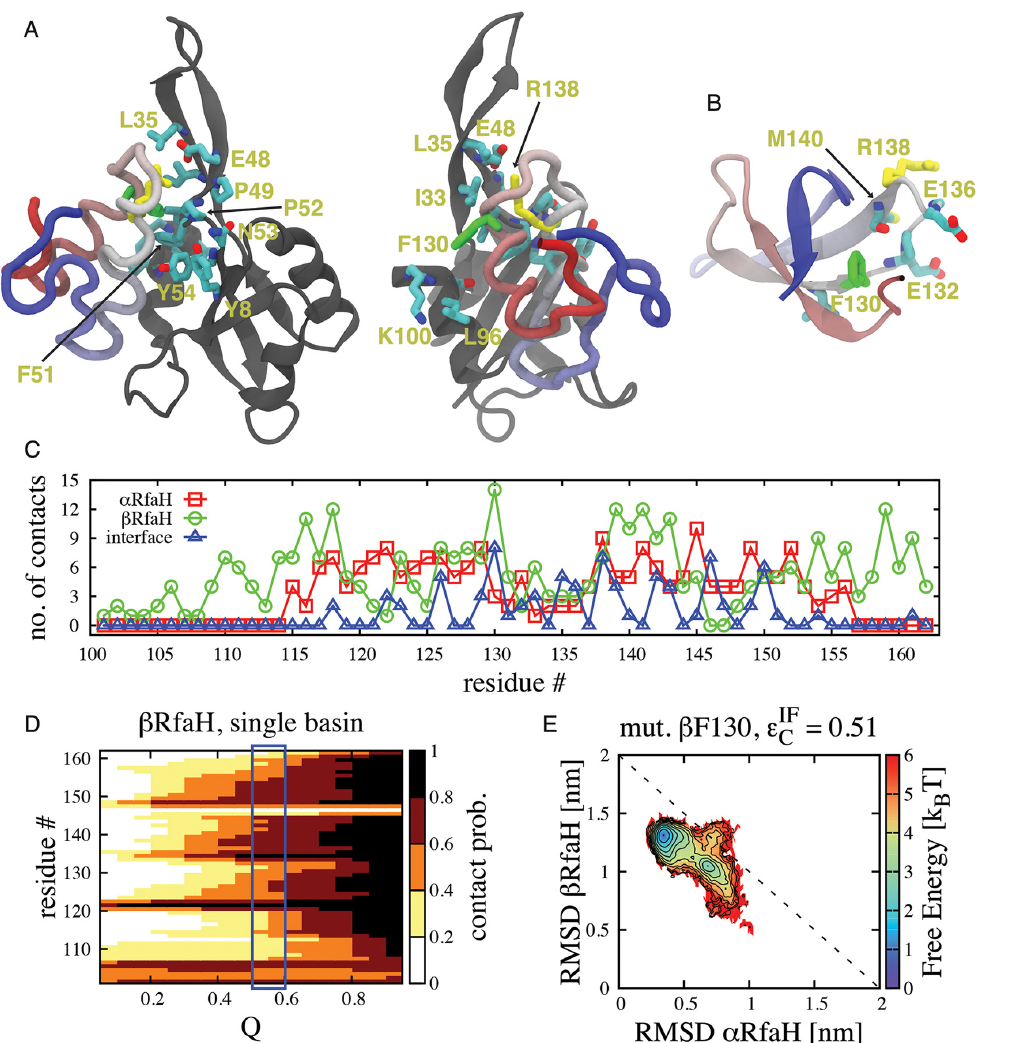
Fig 5. Structural features of the binding TSE that connects the native conformations of RfaH-CTD in dual-basin structure-based models. (A) Stick representation of residues involved in interface contacts between the NTD (gray) and CTD (colored) at the transition state separating I 1 and I 2 that possess a contact probability > 0.5. Of all residues, the most important ones are F130 (green), which forms part of the hydrophobic core of CTD in the β fold (B), and R138 (yellow), which interacts with E48 forming a salt bridge and is exposed on the surface of the CTD in both the α and β folds. (C) Number of native contacts per CTD residue in the α and β folds and also interdomain native contacts in the α fold, highlighting the dual role of residue F130 in stabilizing both states. (D) The contact probability per residue as a function of the folding reaction coordinate Q is shown for β CTD. Its TSE (blue rectangle) is composed by residues that have a contact probability higher than 0.6. (E) Free energy landscape at ε IF C ¼ 0 : 51 ε upon deletion of contacts formed by residue F130 in the β fold, showing that its destabilization leads to favoring the α